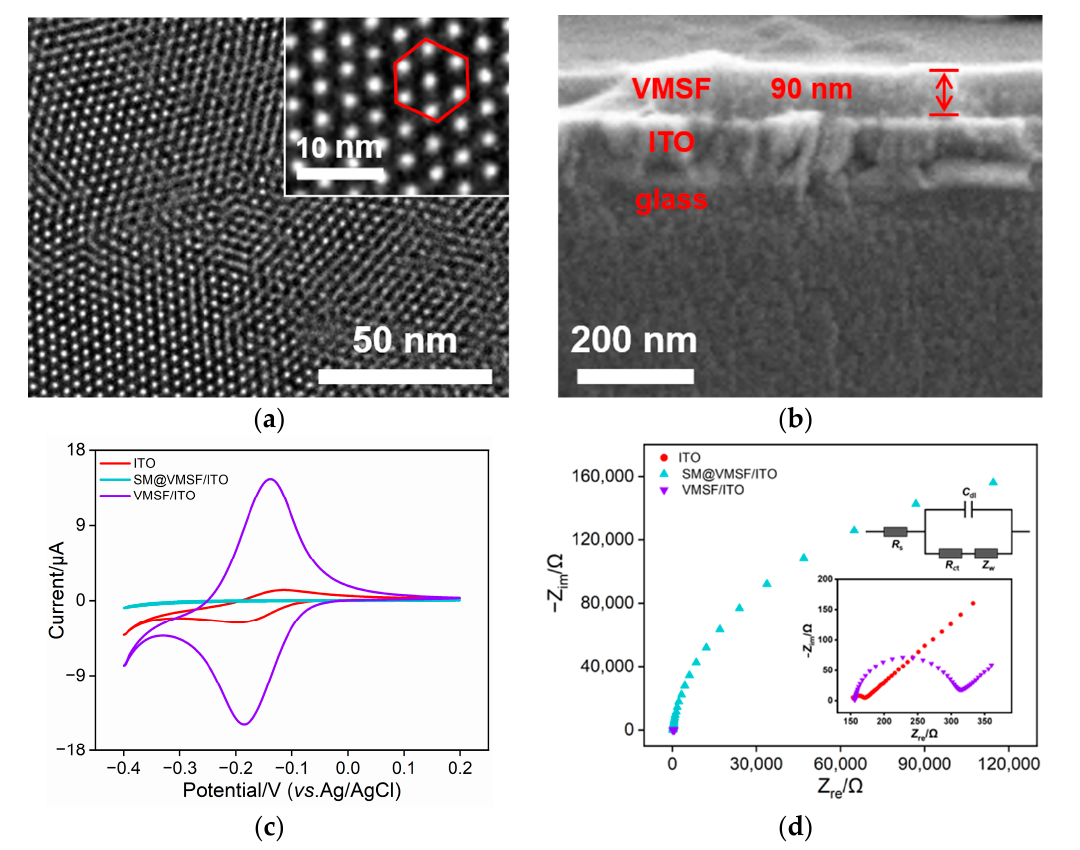
Figure 1. ( a ) Top-view of TEM images and ( b ) SEM image of VMSF. The inset in ( a ) is the corresponding TEM image with high magnification. ( c ) CV plots of ITO, SM@VMSF/ITO, and VMSF/ITO in 0.5 mM Ru(NH 3 ) 63+ and ( d ) EIS plots of ITO, SM@VMSF/ITO, and VMSF/ITO in 0.1 M KCl solution containing 2.5 mM Fe(CN) 63 − /4 − . The scan rate in ( c ) was 0.05 V/s. The insets up and down in ( d ) are the equivalent circuit and magnified EIS plots of ITO and VMSF/ITO, respectively.